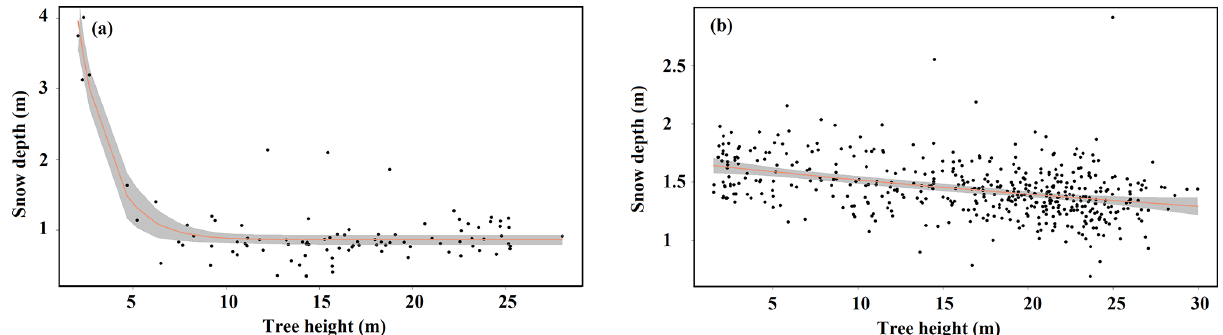
Figure 10. Tree height and snow depth within the 10m transition zone in the south direction for (a) site A and (b) site K. The exponential and linear fit is shown with a red line along with 95% confidence interval